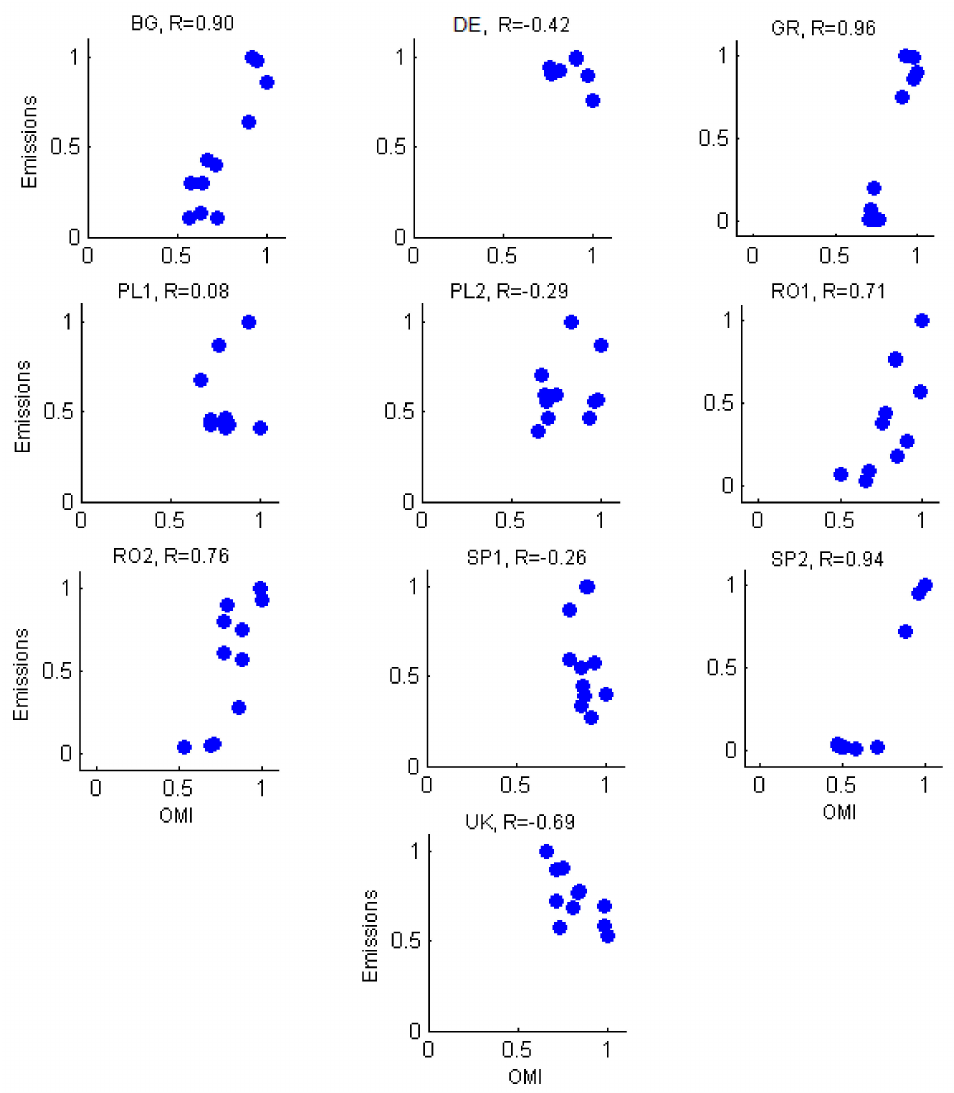
Figure 8. Scatter plots of OMI measurements vs. emissions for SO 2 (normalized